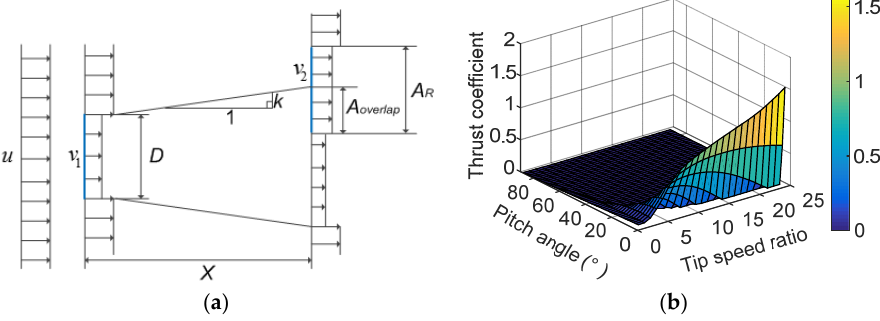
Figure 3. ( a ) Speed relationship between the upstream ( v 1 ) and downstream wind turbine ( v 2 ) in Katic wake model; ( b ) thrust coefficient of the NREL 5 MW wind turbine.